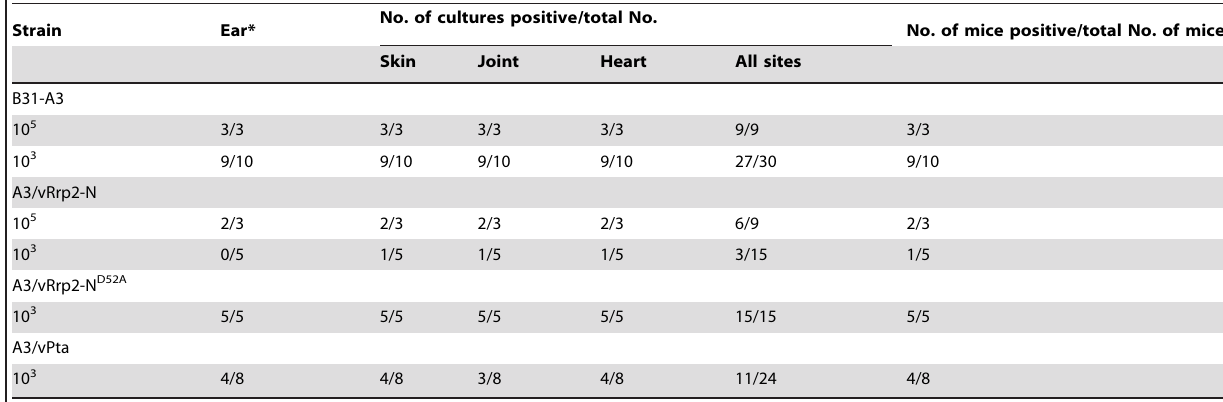
Table 3. Mouse infectivity of Borrelia burgdorferi with overproduction of Rrp2-N or Pta. No. of cultures positive/total No. Strain Ear*